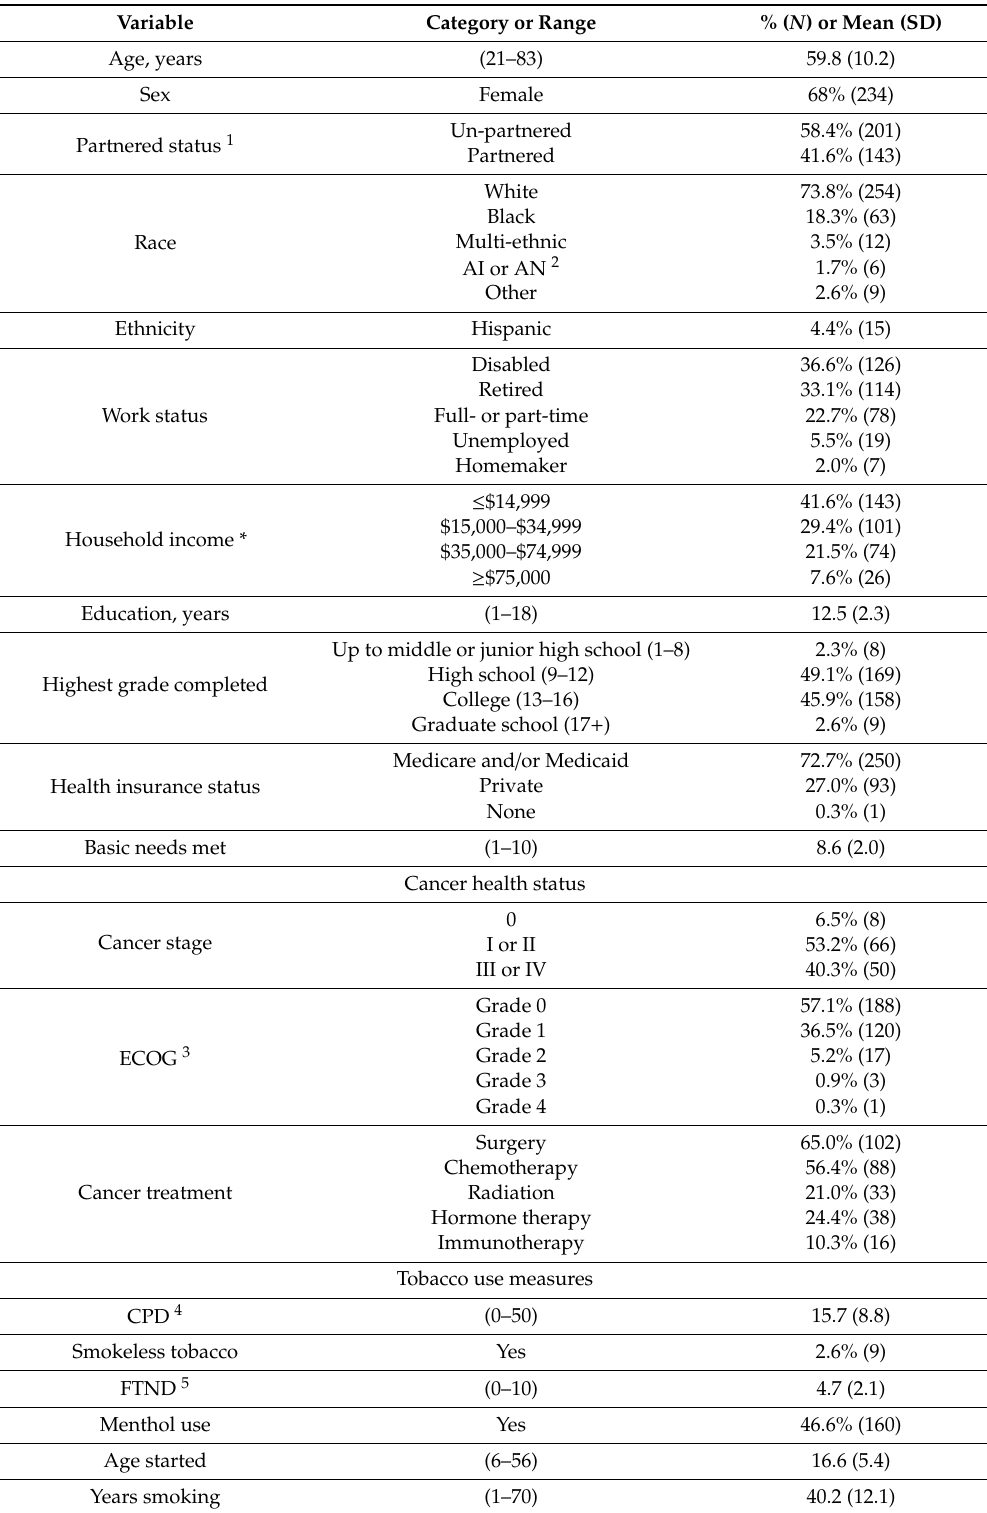
Table 1. Participant characteristics: Agreed to treatment ( n = 344) including those who attended ( n = 217) and those who did not attend ( n = 127)